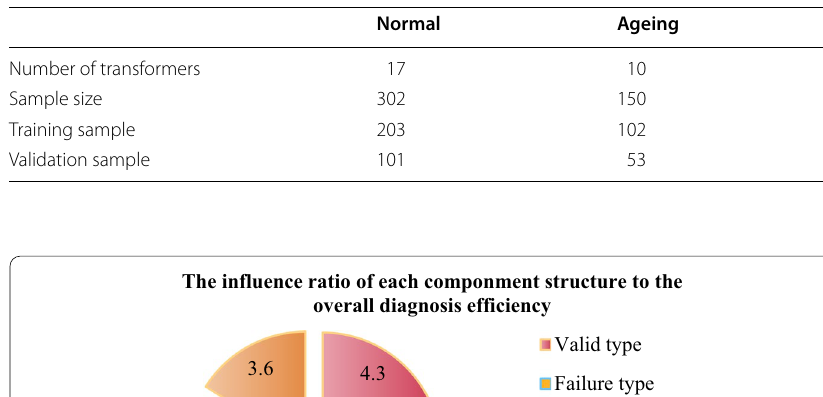
Table 11 Training sample statistics